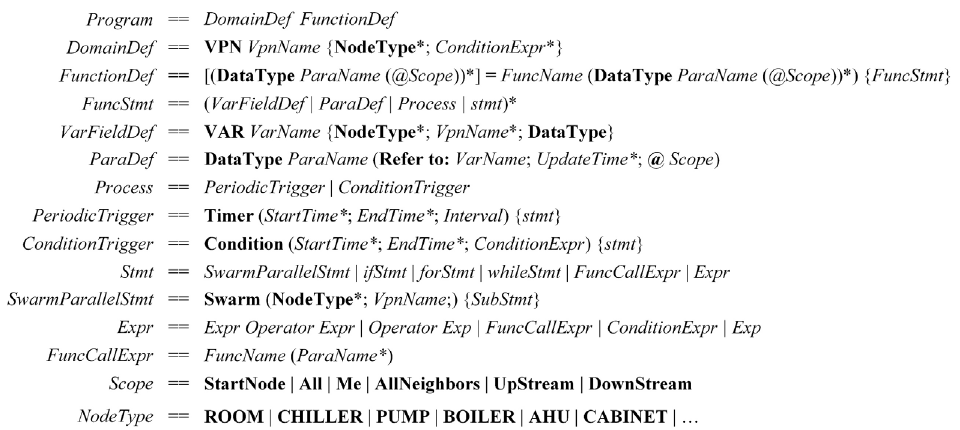
Figure A1. Core part of SwarmL syntax. (Bold and * indicates keyword and many.)